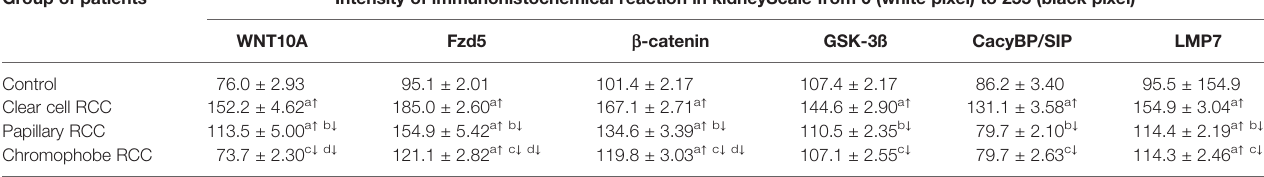
TABLE 2 | The intensity of immunoreaction determining WNT10A, Fzd5, b -catenin, GSK-3ß, CacyBP/SIP, LMP7 in clear cell RCC, papillary RCC, chromophobe RCC, and non-malignant renal tissue (mean ± SE). Group of